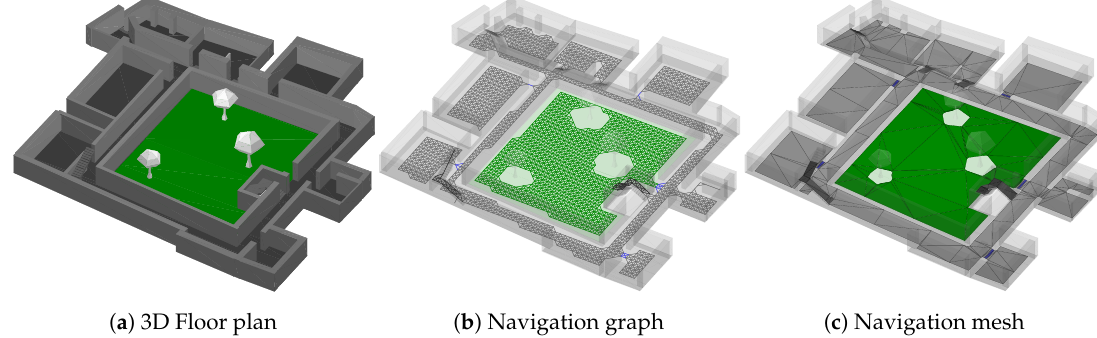
Figure 1. Floor plan ( a ) and automatically generated transition data structures ( b , c ) for the ground floor of the historic building (71m × 53m). To reach every nook and cranny, the generated graph ( b ) requires many nodes and edges. The depicted version uses a coarse node-spacing of 90cm (1700 nodes) but barely reaches all doors and stairs. A navigation mesh generated for the same building required only 320 triangles ( c ) and reaches every corner within the